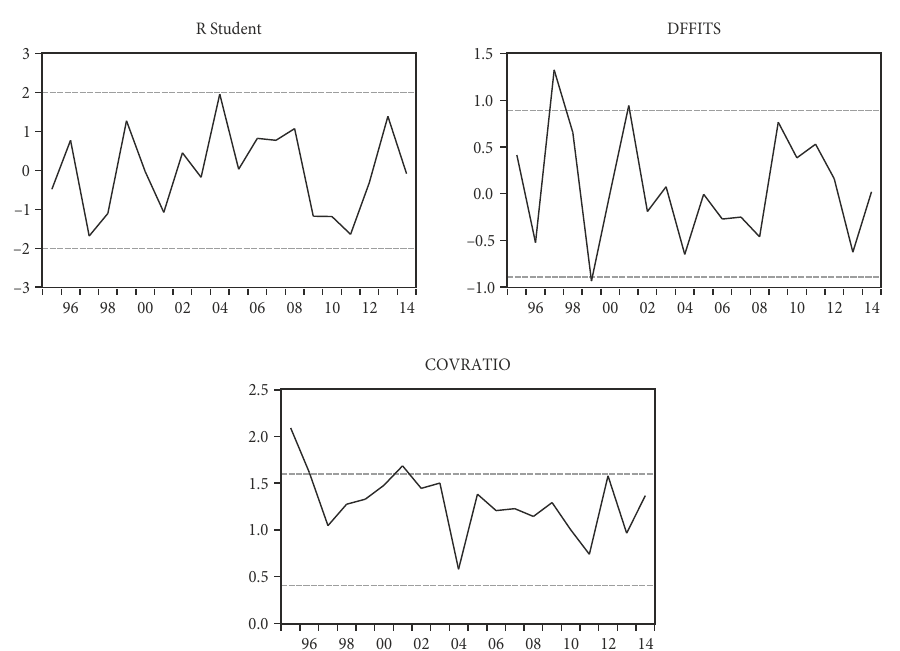
Figure 10. The influence statistics plots (source: authors’ own